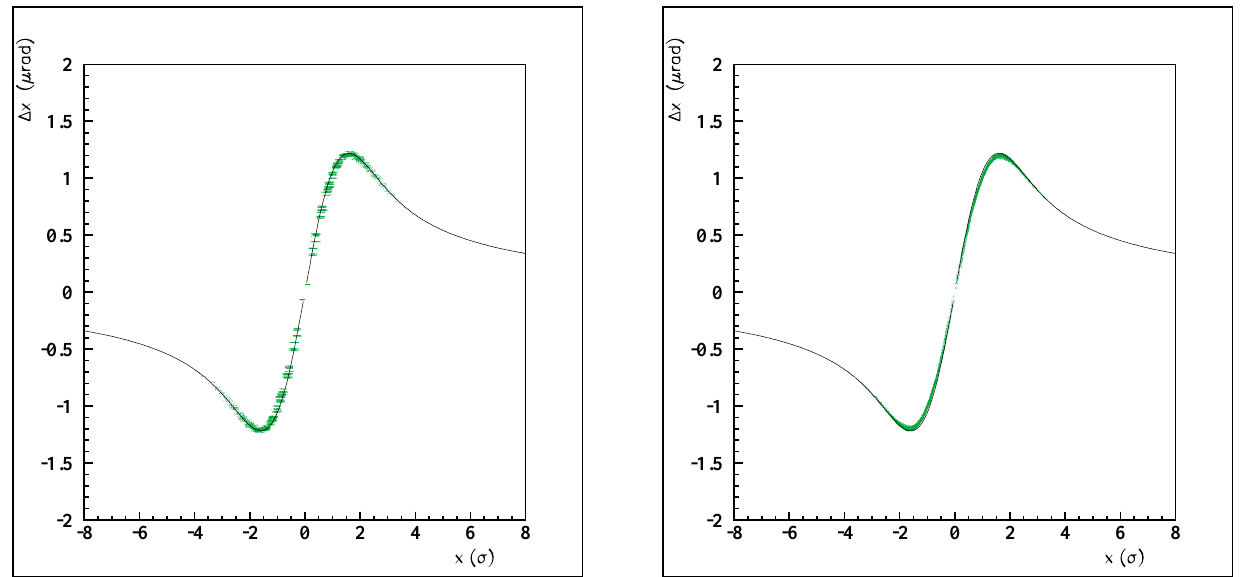
FIG. 1. (Color) Beam-beam kick as calculated with HFMM (points) and from analytical expression (solid line) for round beams with Gaussian distribution. Left: 0.25 s grid ( 81 3 81 ) and nearest-grid-point assignment. Right: CIC assignment. distribution at a distance x (cid:1) L x s x . This assumes that a closed orbit exists [11] and the bunches oscillate coherently around this orbit. At the LHC, there are about n par (cid:1) 16 parasitic encounters on each side of an IP, with a mini- mum transverse separation of L x (cid:1) 7.5 (in units of s x ). The fractional parts of the horizontal and vertical tunes are 0.31 and 0.32, and, unlike the Large Electron Positron Collider (LEP) [13], the results are not strongly affected by dynamic beta effects. In Figs. 1 and 2 we show com- parisons between the beam-beam kicks calculated with the